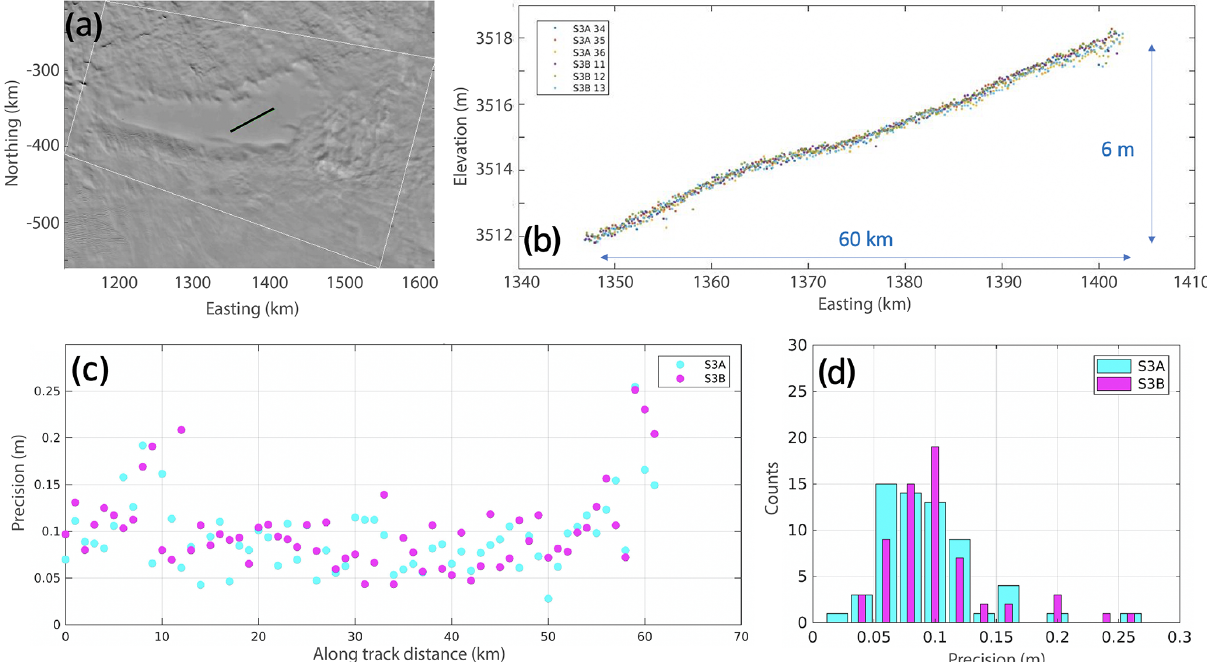
Figure 2. Assessment of Sentinel-3A and Sentinel-3B instrument precision at Lake Vostok site. (a) Location of the ground track crossing the central part of the lake (shown in black), which was used to assess precision; the background image is taken from the MODIS Mosaic of Antarctica (Haran et al., 2006). (b) Repeated elevation profiles acquired during Sentinel-3A cycles 34–36 inclusive and Sentinel-3B cycles 11–13 inclusive. (c) The standard deviation of Sentinel-3A and Sentinel-3B elevation measurements in 1km intervals along the satellite track. (d) The distribution of the 1km interval standard deviations for Sentinel-3A and Sentinel-3B; there is no significant difference in S3A and S3B precision at this site, at the 5% significance level. In panels (a) – (c) , the geographical coordinates refer to a WGS84 Antarctic Polar Stereographic projection with a central meridian of 0 ◦ and a standard parallel of 71 ◦